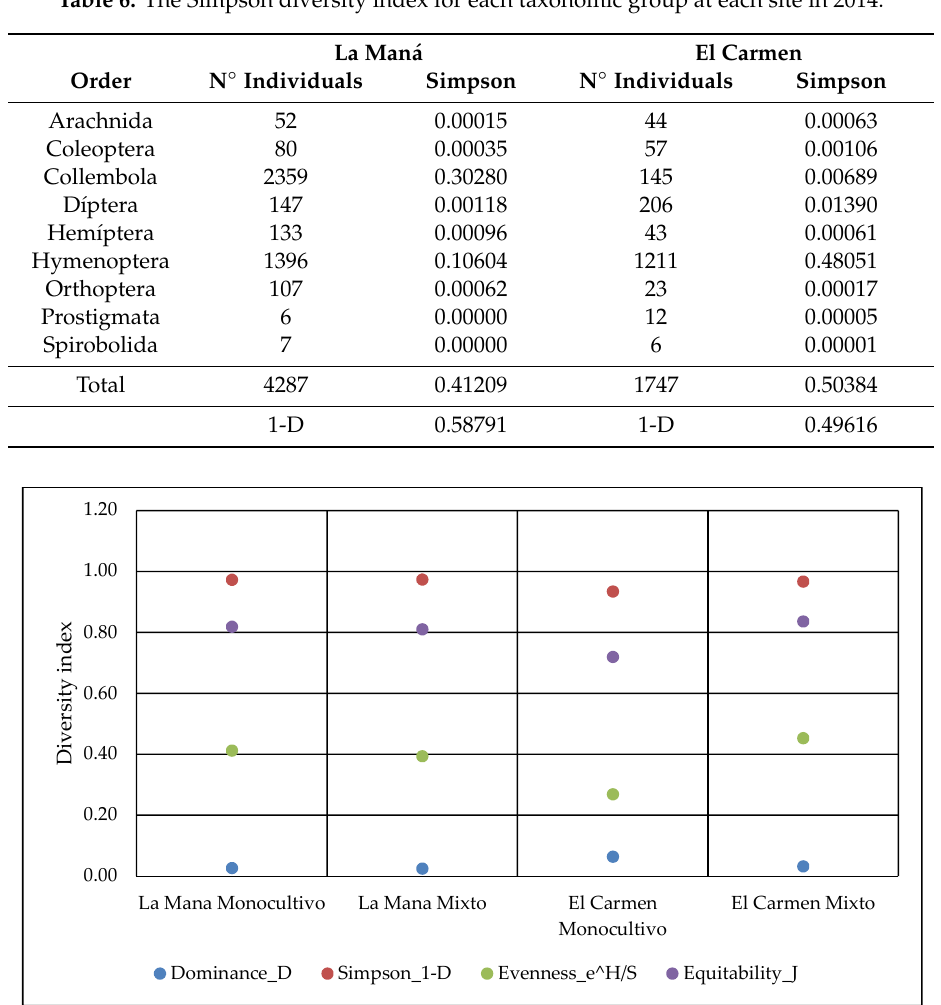
Table 6. The Simpson diversity index for each taxonomic group at each site in 2014.